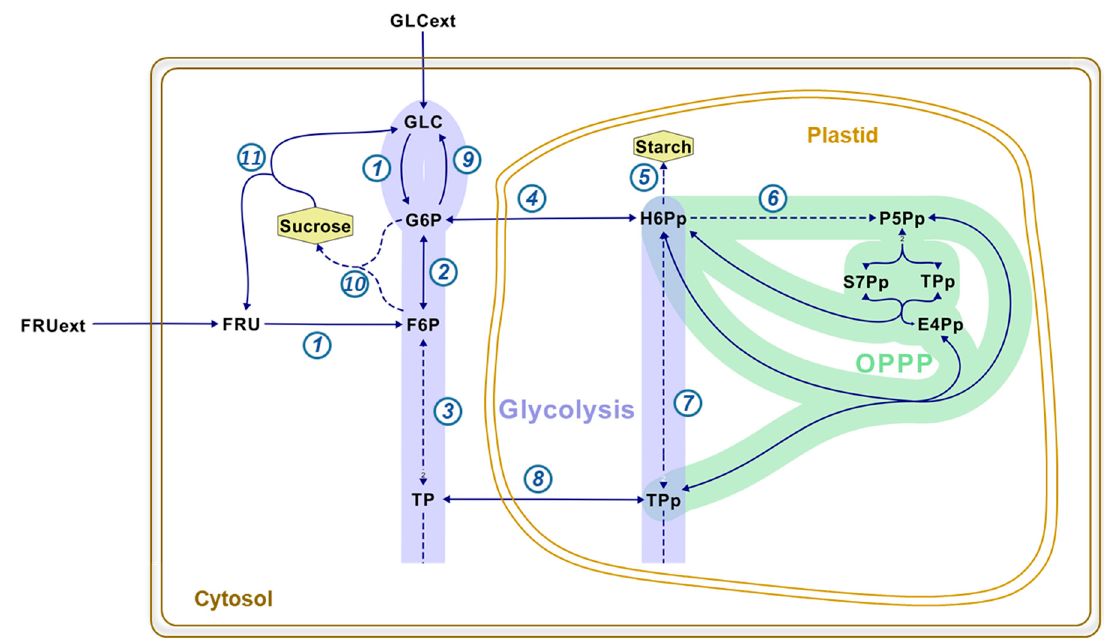
Figure 1. Representative example of maize embryos to illustrate the subcellular compartmentation of hexose-phosphates in plant cells. Developing maize embryos mainly import glucose and fructose as carbon sources. These sugars get phosphorylated into hexose-phosphate in the cytosol. The resulting hexose-phosphates are involved in major pathways: glycolysis (purple), and the oxidative pentose-phosphate pathway (OPPP; green). Full and dashed arrows represent one reaction or a multiple-step reaction, respectively: 1 is hexokinase; 2, phosphoglucose isomerase; 3 and 7, cytosolic and plastidial aldolases, respectively; 4 and 8, exchange of hexose-phosphates and triose-phosphates between cytosol and plastid, respectively; 5, starch synthesis; 6, oxidative part of the OPPP; 9, glucose 6-phosphatase; 10, sucrose phosphate synthase; and 11, invertase. Abbreviations in alphabetical order: E4Pp, plastidic erythrose 4-phosphate, FRU(ext), (extracellular) fructose; F6P, fructose 6-phosphate; GLC(ext), (extracellular) glucose; G6P, glucose 6-phosphate; H6Pp, plastidic hexose-phosphates; P5Pp, plastidic pentose-phosphates; S7Pp, plastidic sedoheptulose 7-phosphate; TP(p), (plastidic) triose-phosphates.